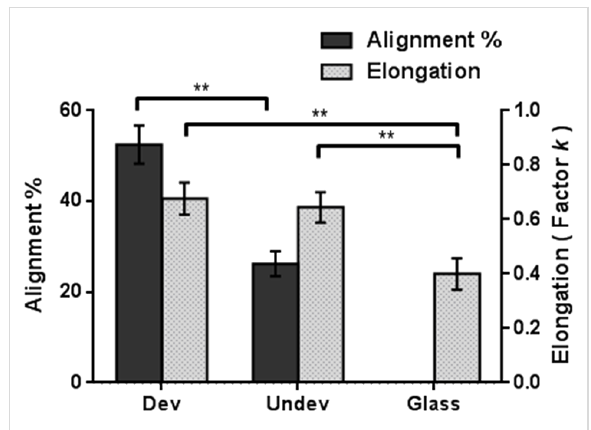
Figure 6: The alignment rate (alignment %) and the elongation factor of the L929 cells cultured on the developed and undeveloped SU-8 films and on the reference glass substrate. Data are expressed as mean ± s.e.m. of four samples, n = 150 cells, ** p <